Question: Give a one-sentence summary of this figure.
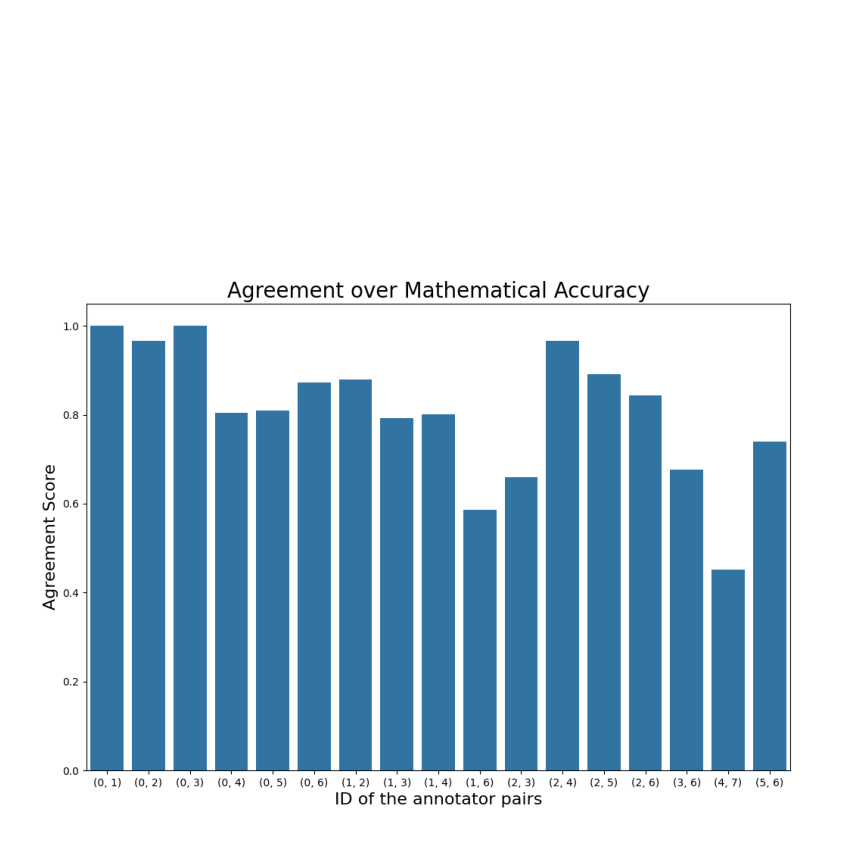
Answer: Annotator Agreement over the Mathematical Accuracy of a given reasoning step